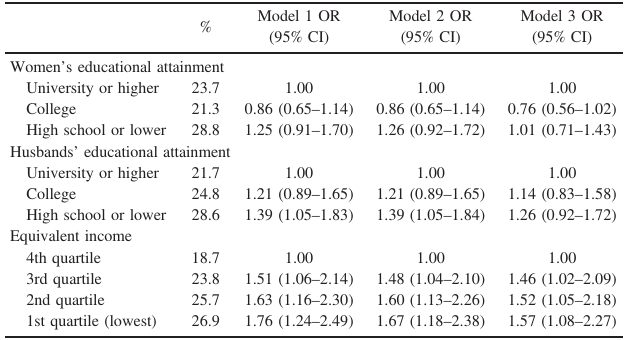
CI, con fi dence interval; OR, odds ratio. Model 1: adjusted for age and municipality. Model 2: model 1 + adjusted for employment status and psychological